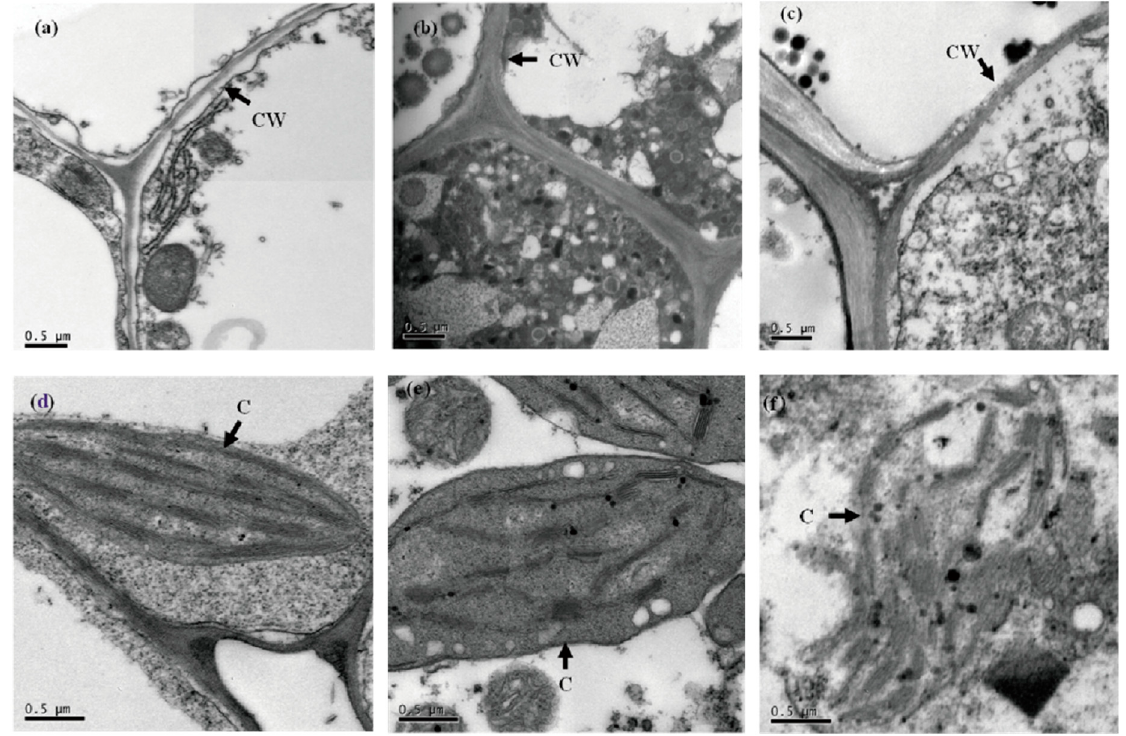
Figure 6. Transmission electron micrographs of lettuce root and leaf cells after 14 days of treatment under different SD concentrations: lettuce root under ( a ) control, ( b ) 2 mg/L, and ( c ) 10 mg/L; lettuce leaf under ( d ) control, ( e ) 2 mg/L, and ( f ) 10 mg/L. C denotes cell wall and CW denotes chloroplasts.